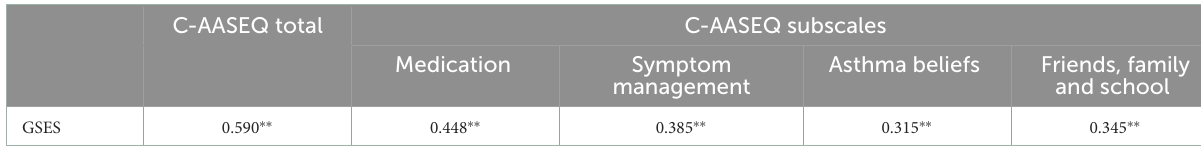
TABLE 4 Pearson’s correlations between the Chinese Adolescent Asthma Self-Efficacy Questionnaire (C-AASEQ) scale and subscales and the Generalized Self-Efficacy Scale